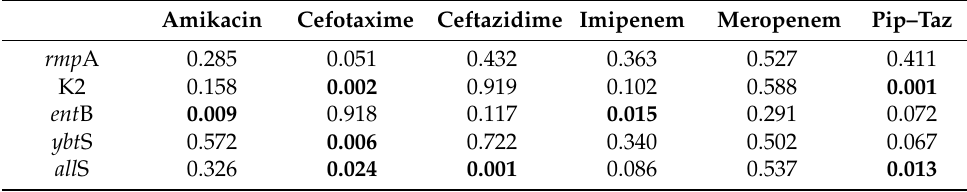
Table 3. Mann–Whitney U test p -values for modification of antibiotic MIC by virulence